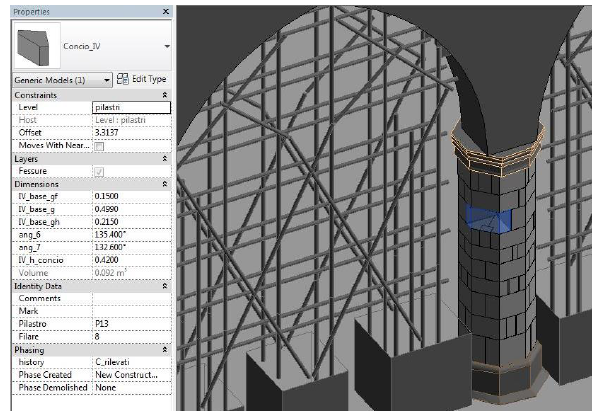
Figure 13. 3D detail of the ©Revit model of the columns and their stone elements.